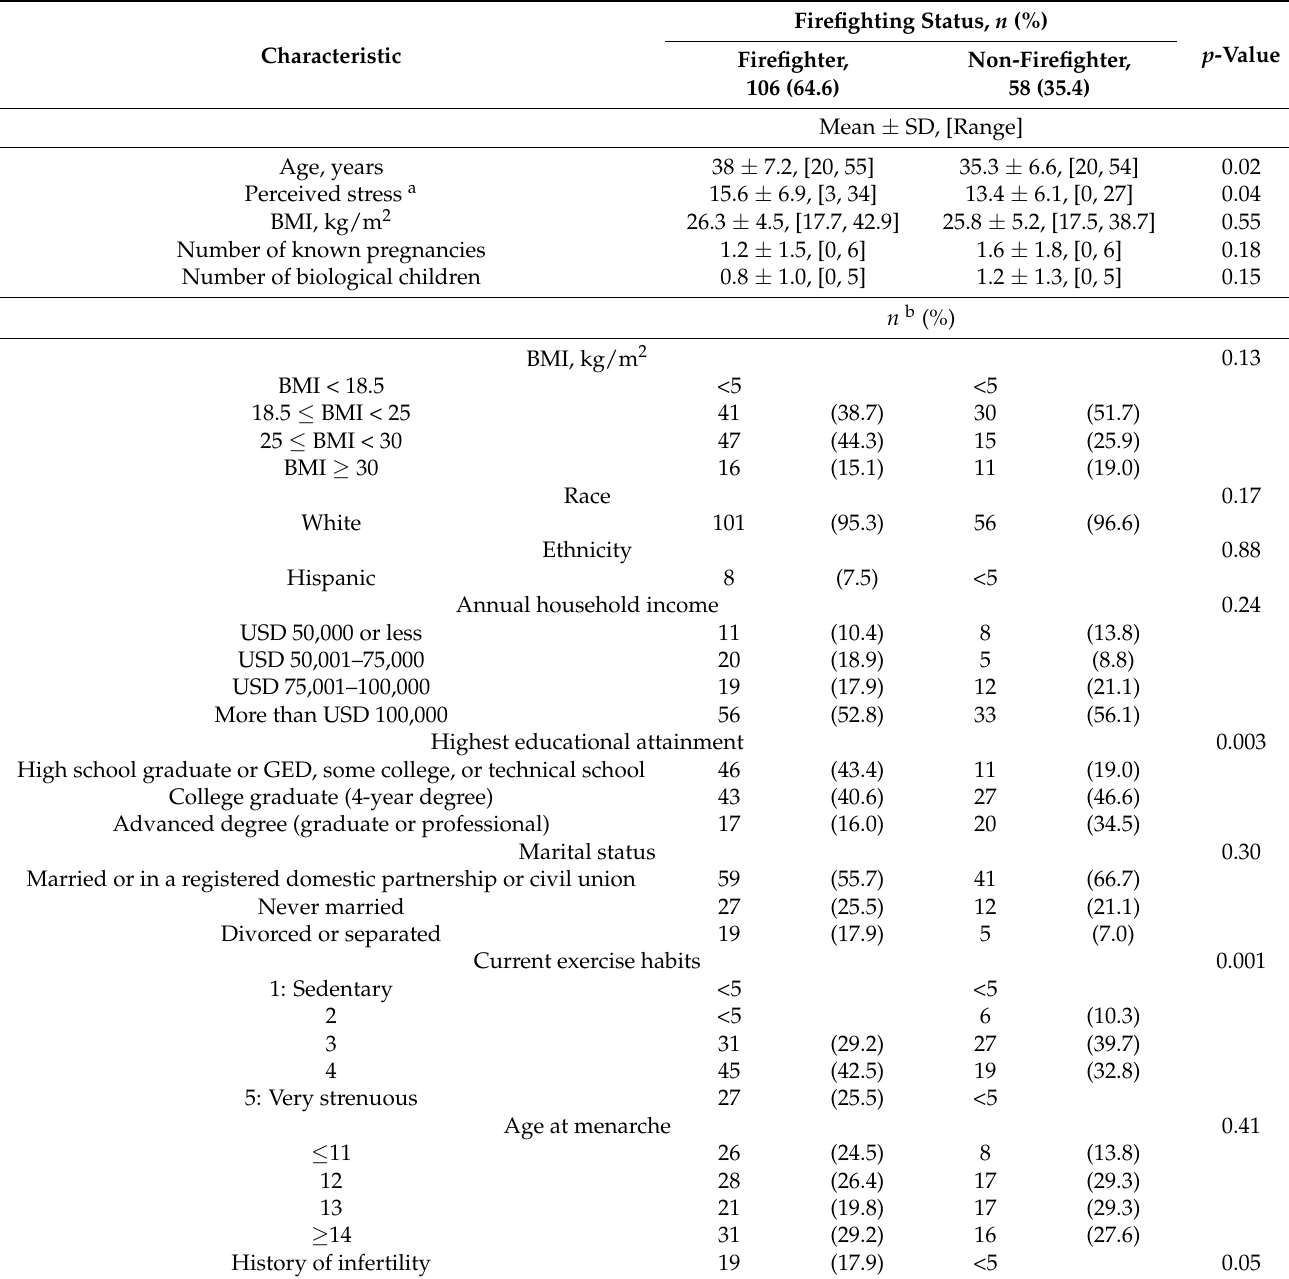
Table 1. Demographic characteristics of study sample stratified by history of employment as a firefighter ( n =